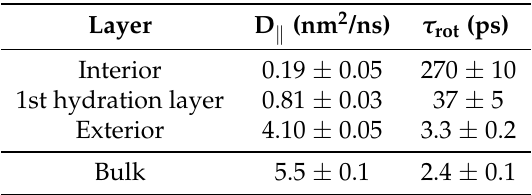
Figure 8. Density of water molecules confined between stacked DMPC bilayers with hydration level ω = 4, 7, 15, 34, as a function of the membrane distance ξ with respect to one of the two confining membranes. We define three relevant regions: (i) interior of the membrane, with ξ < 0; (ii) first hydration layer, with 0 < ξ < 5 Å; (iii) exterior of the membrane, with ξ > 5 Å. Table 4. Diffusion coefficient D in the xy -plane parallel to the membrane and rotational dipolar (cid:107) relaxation time τ rot , both averaged over the water molecules in different regions of the water–membrane interface at ω = 34, compared with the values for bulk water at same thermodynamic conditions ( P = 1 atm, T = 303